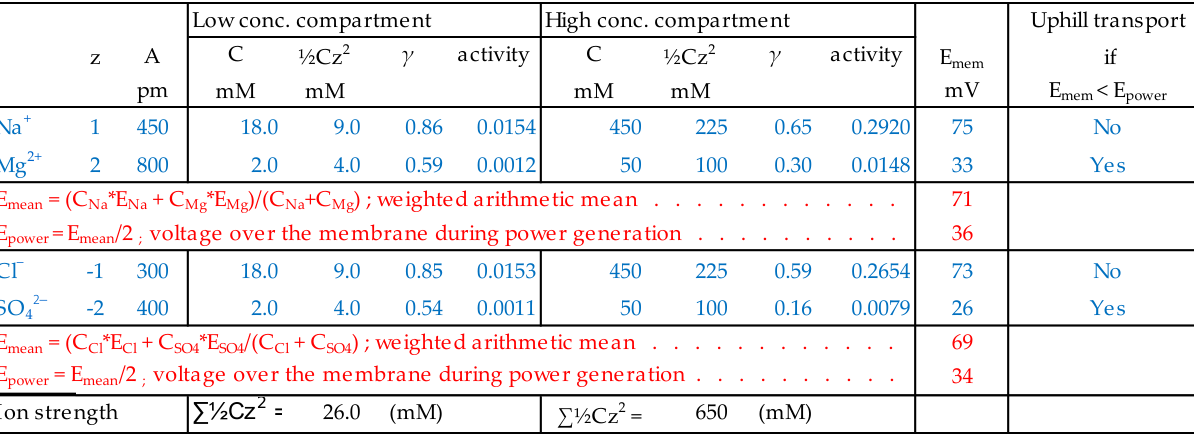
Figure 2. Decision scheme for uphill transport in the case of equal relative composition of High and Low feed waters.